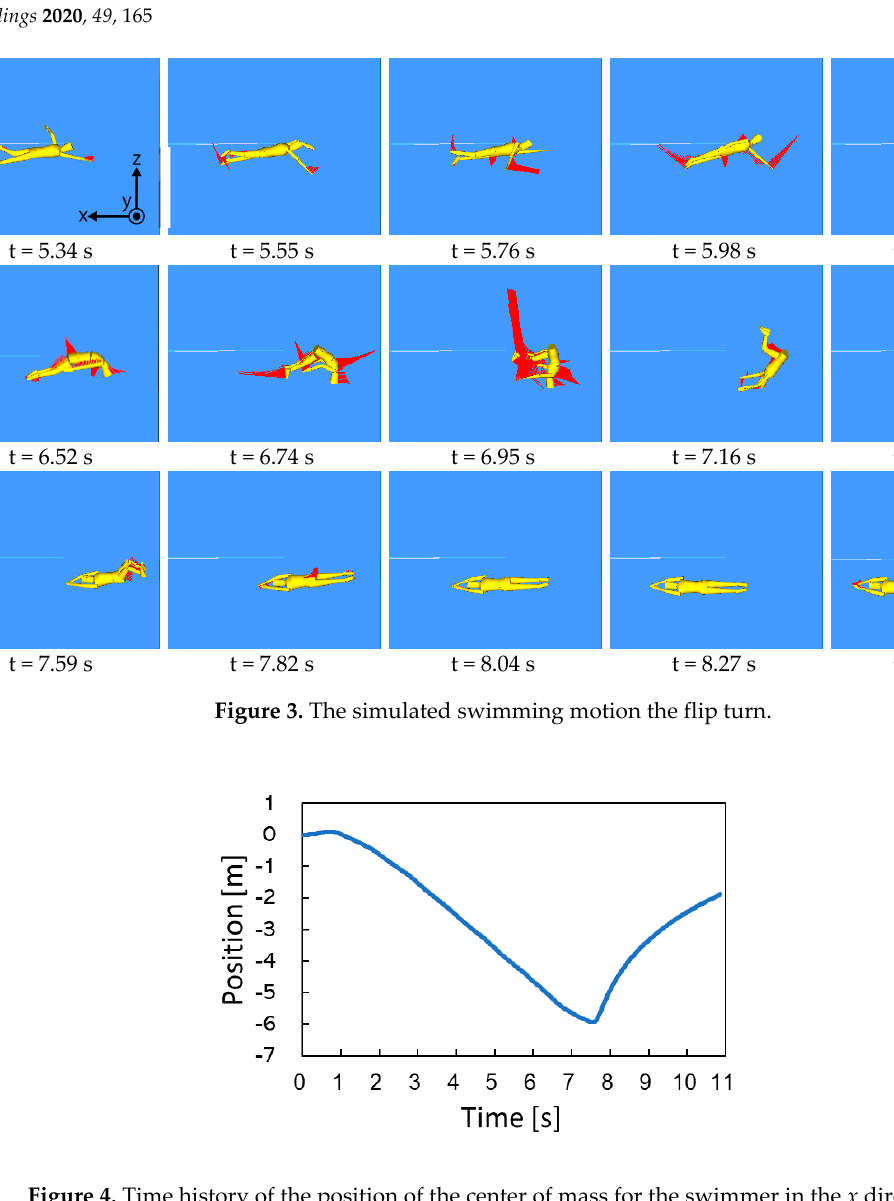
Figure 4. Time history of the position of the center of mass for the swimmer in the x direction.